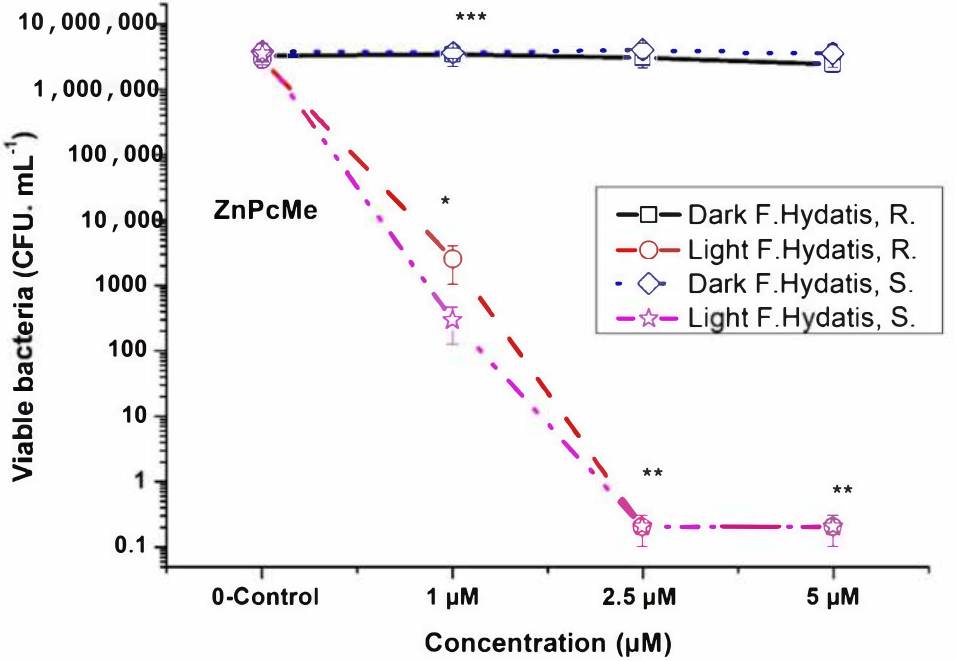
Figure 4. Photodynamic inactivation of F. hydatis ( R and S ) planktonic cultured with peripheral Zn(II)–phthalocyanine (ZnPcMe) and LED 665 nm irradiation. * p < 0.005; ** p < 0.008 and *** p <